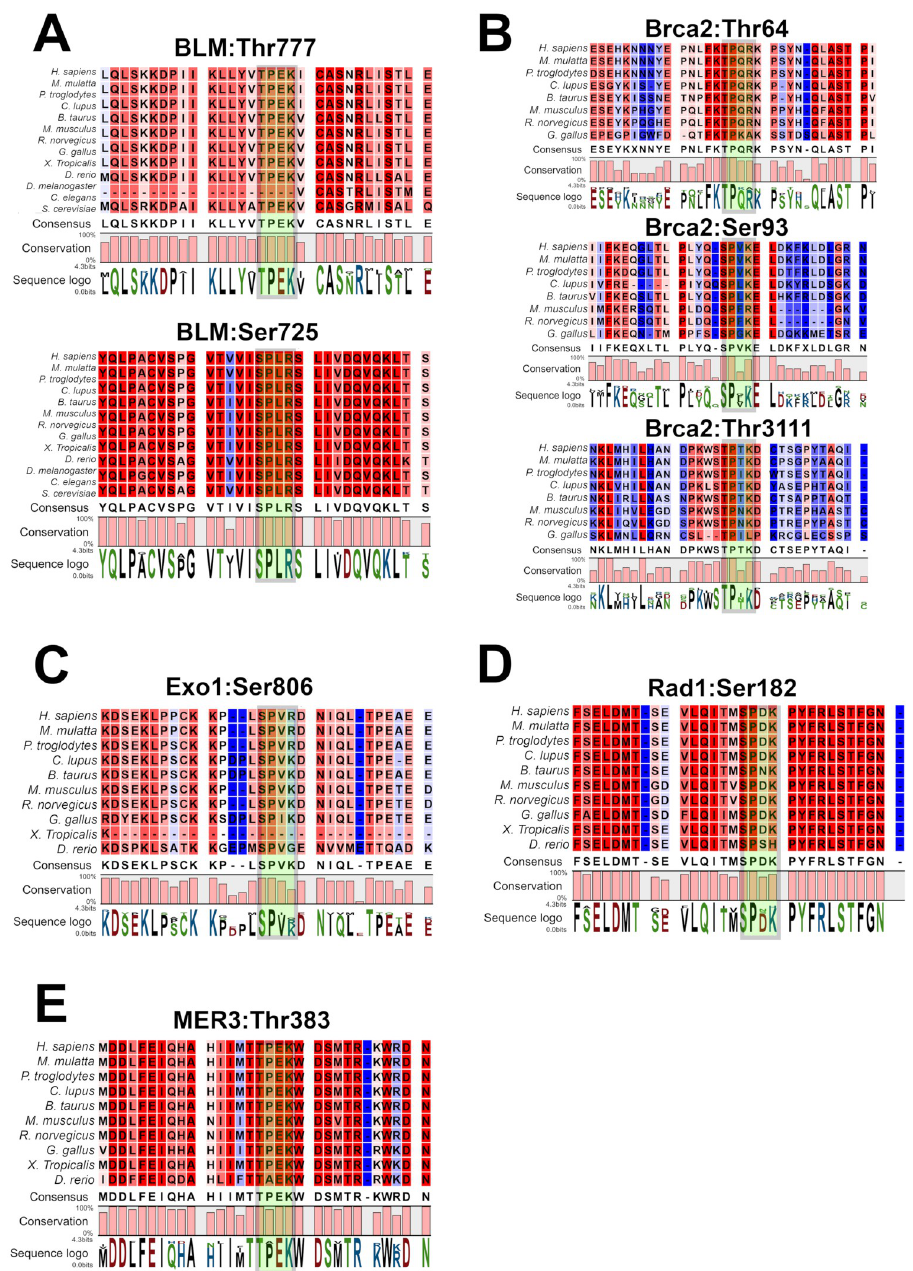
Fig 7. Other potential meiotic substrates of CDK2. Sequence alignment of the evolutionary conservation of various potential CDK consensus sites in meiotic proteins: BLM Thr777/Ser725 (A), BRCA2 Thr64/Ser93/Thr3111 (B), Exo1 Ser806 (C), RAD1 Ser182 (D), and MER3 Thr383 (E). Amino acid positions are labelled relative to the transcripts from Mus musculus . The CDK consensus site in each sequence is highlighted by a green